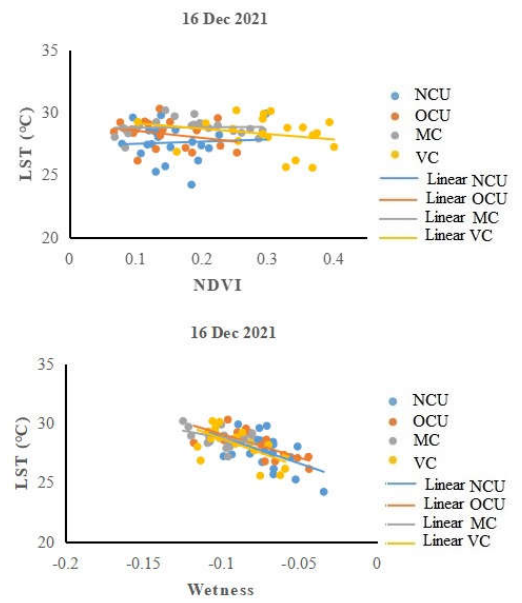
Figure 5. LST vs NDVI and TCT based Wetness for different residential community types as recorded by a specific observation of the Landsat-8 OLI/TIRS acquired on 16 December